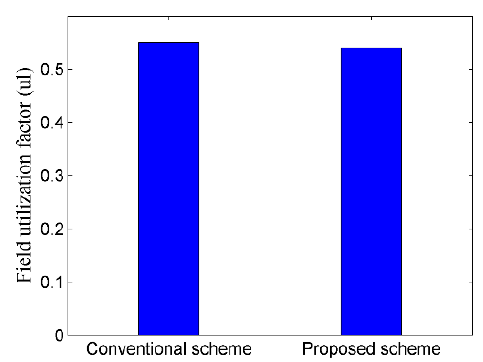
Figure 23. Field utilization factor comparison for conventional and proposed GIL schemes.